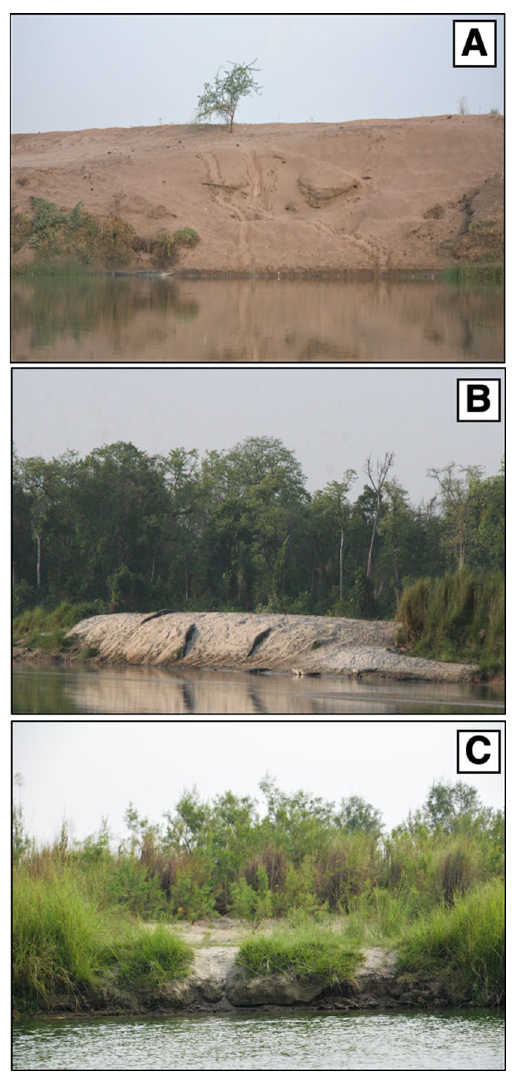
Figure 2. Nesting site of gharial in different habitats. (A) A gharial nesting site on Chambal river in National Chambal sanctuary, Madhya Pradesh. This site represents a typical sandy river bank which gharials naturally prefer for nesting. (B) A gharial nesting site in Girwa river in Katerniaghat before 2010 flood-channel shift. (C) Gharial nesting site N4 in Girwa river in 2018, post channel shift. (Image credits: (A) Suyash Katdare; (B) R.